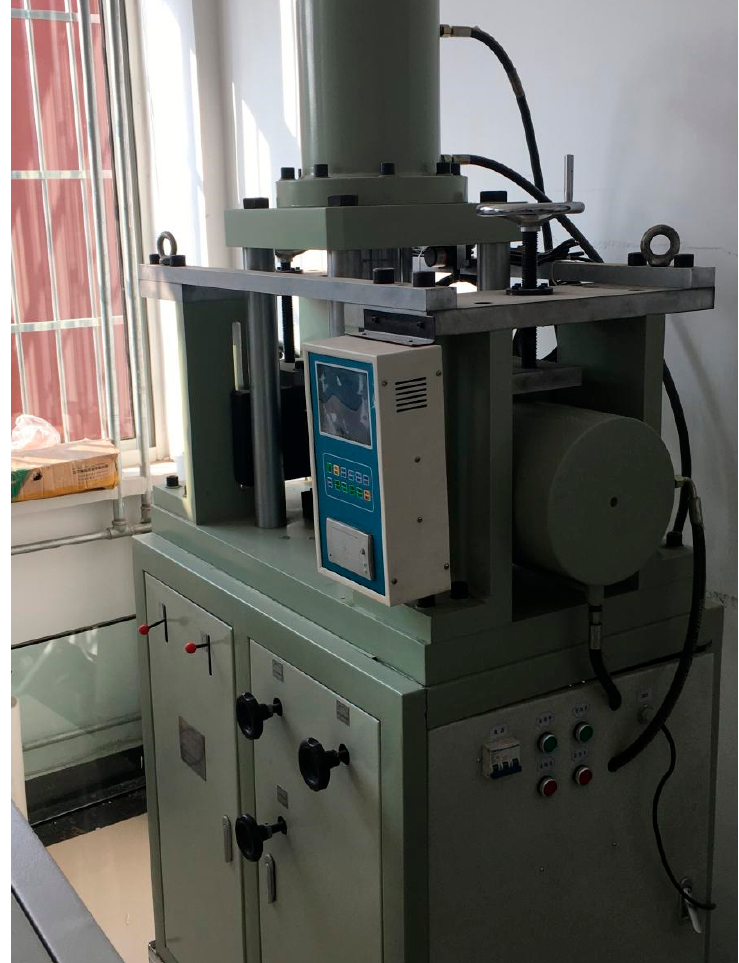
Figure 4. Direct shear instrument.